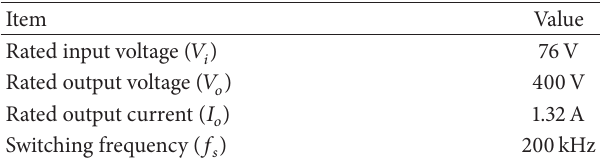
Table 2: Converter